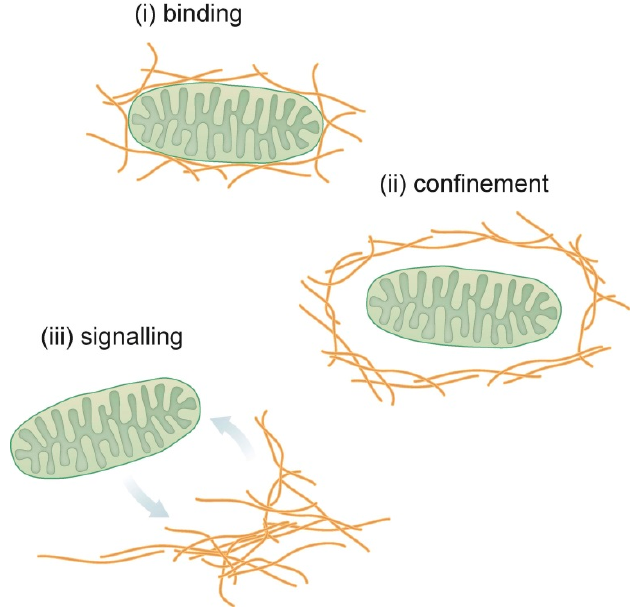
Figure 1. Schematic representation of different modes of interaction between intermediate filaments and mitochondria.